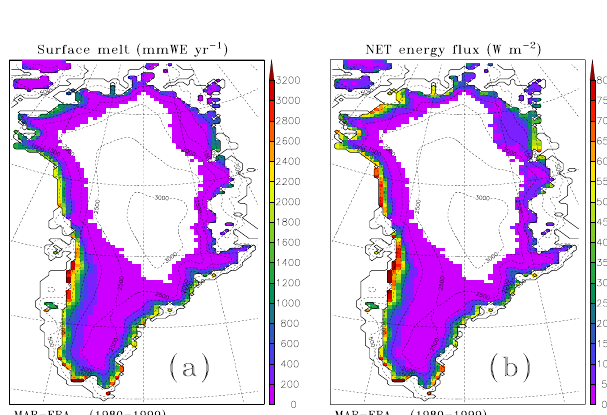
Fig. 2. (a) Average annual melt (mmWEyr − 1 ) of MAR-ERA Int over the 1980–1999 period. The surface height (m) is drawn in dashed line. (b) Average net energy flux (Wm − 2 ) available at the surface of the ice sheet for enabling the melt in (a)